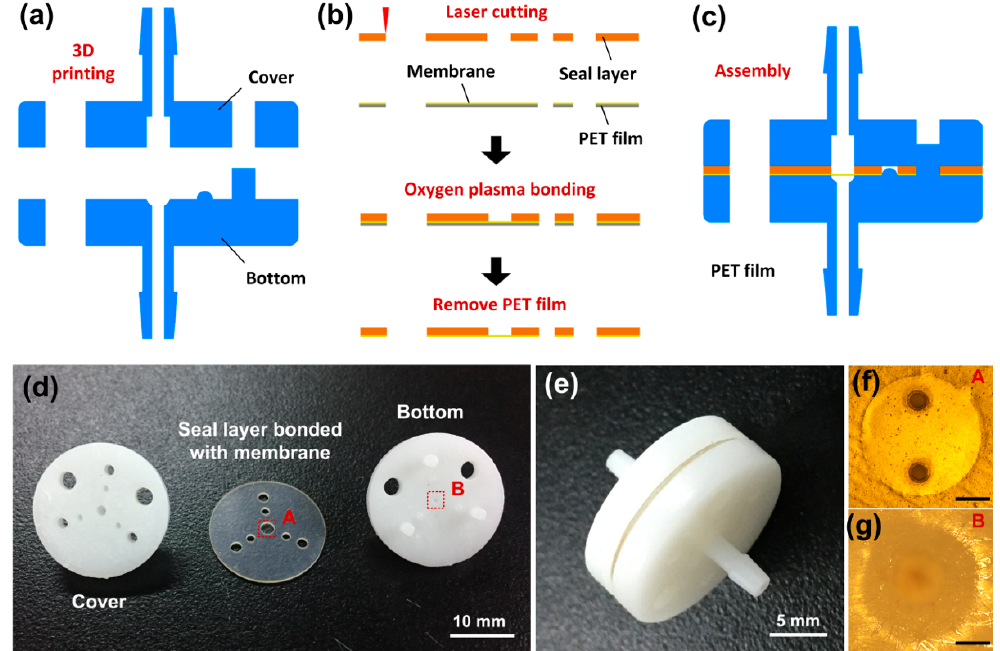
Figure 4. Fabrication of the microfluidic passive valve. Schematics of the valve fabrication, ( a ) 3D printing of the cover and the bottom, ( b ) UV laser micromachining of the seal layer and the membrane, and ( c ) assembly of the valve. ( d ) Photograph showing the prototype functional parts of the valve. ( e ) Photograph showing a prototype of the assembled valve. ( f ) Image showing the micro-holes in the membrane at position A in Figure 4d. ( g ) Image showing the ellipsoid surface of the bottom at position B in Figure 4d. Scale bar in Figure 4f,g was 500 µm.